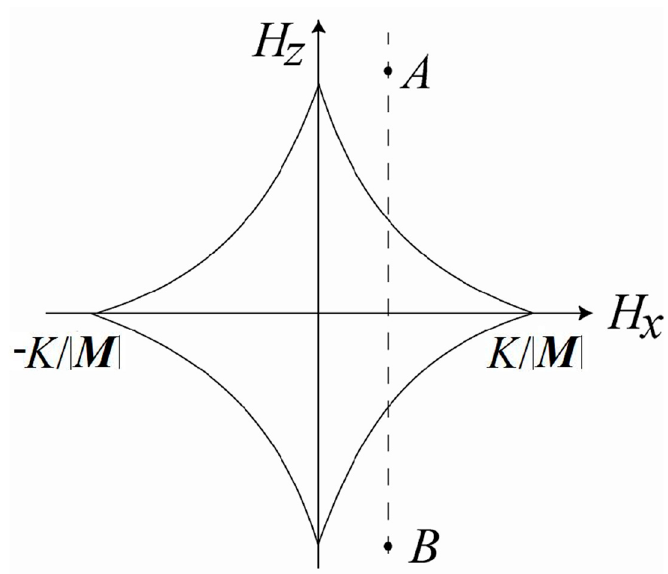
Figure 5. Functional dependence of H z on H x simulating the Stoner-Wohlfarth model.